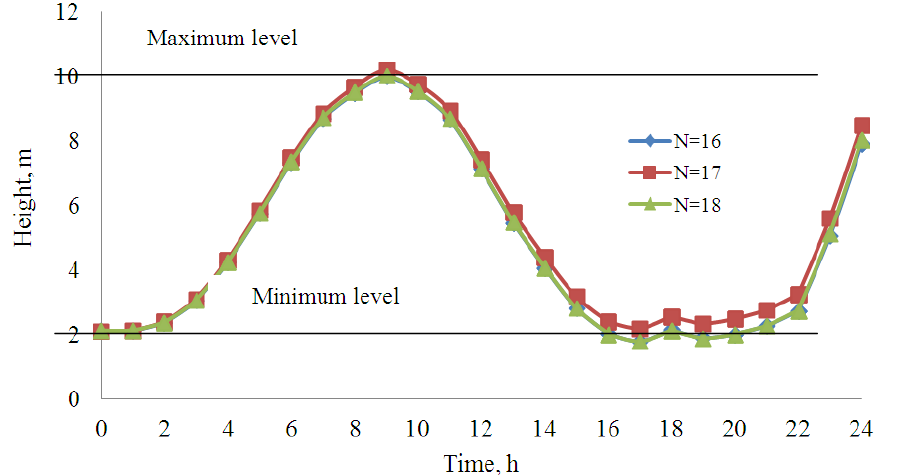
Figure 11. Storage tank level profiles (case